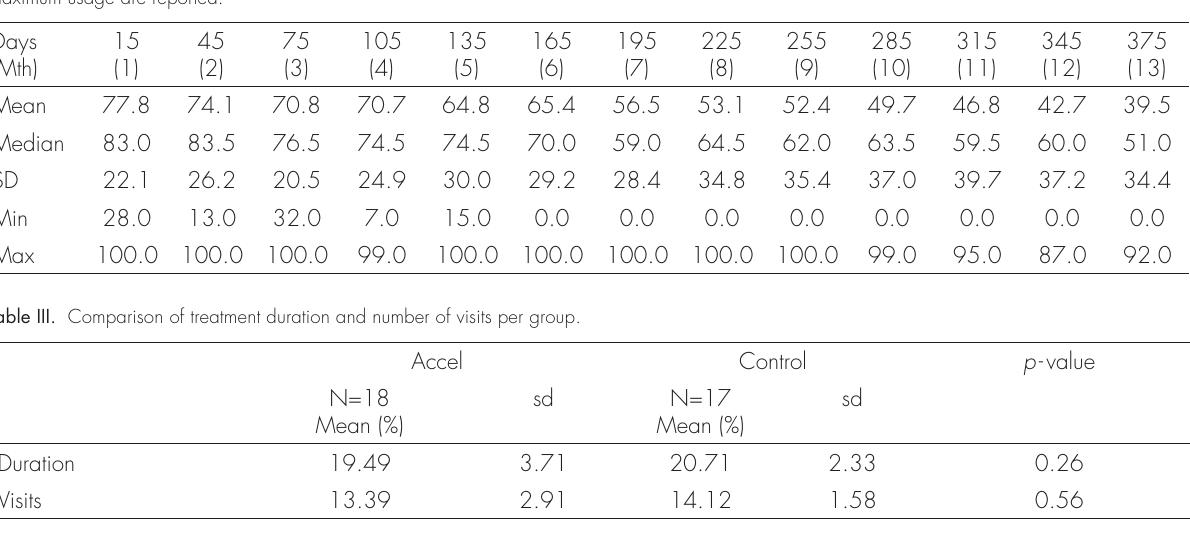
Table II. Compliance data reported every 30 days starting from day 15 and over ~13 months. The mean, median, standard deviation, minimum and maximum usage are reported.